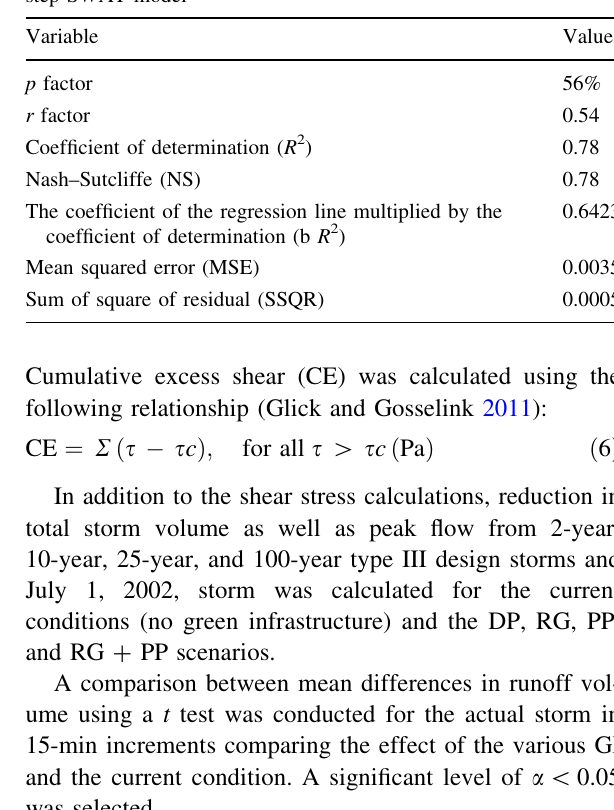
Table 3 Stream flow calibration results for sub-hourly 15-min time step SWAT